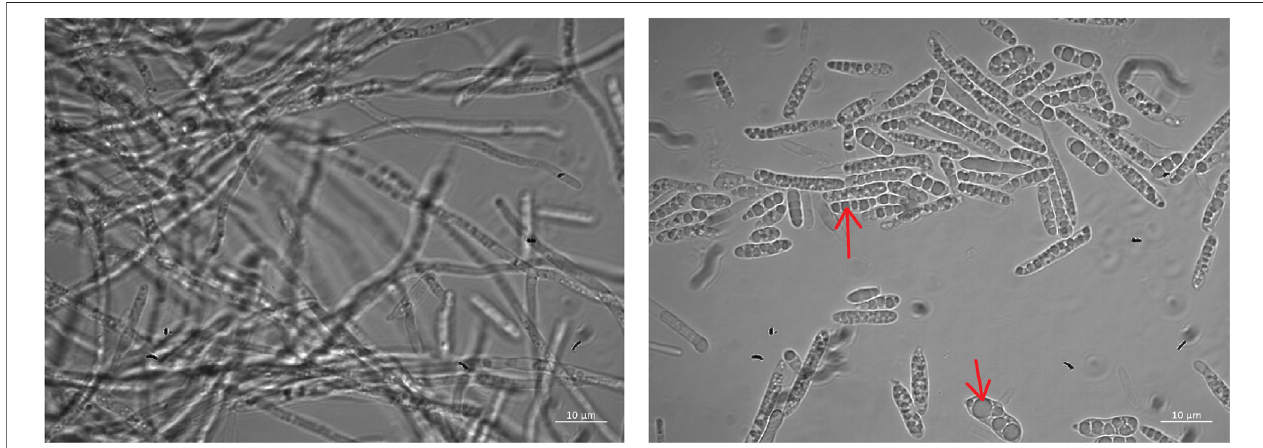
FIGURE 1 | Microscope images of M. aphidis cells during growth (left) and MEL production (right). Arrows indicate visible storage globules inside the cells.